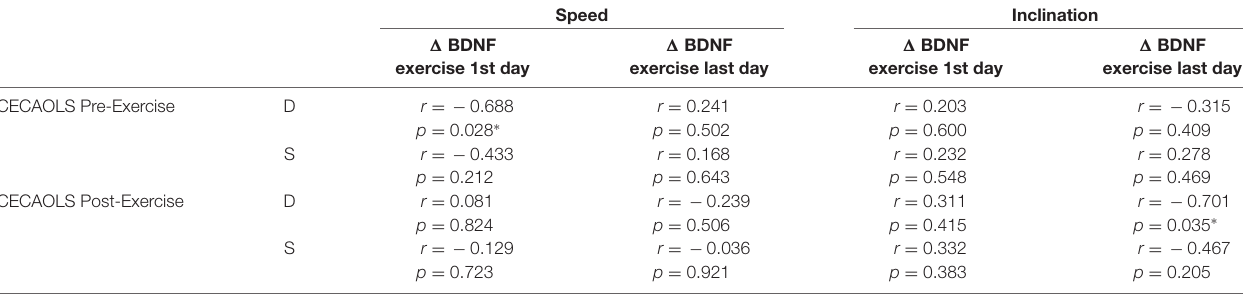
TABLE 3 | Correlation of CECAOLS and BDNF changes in both groups before and after training. Speed Inclination ∆ BDNF ∆ BDNF ∆ BDNF exercise 1st day exercise last day exercise 1st